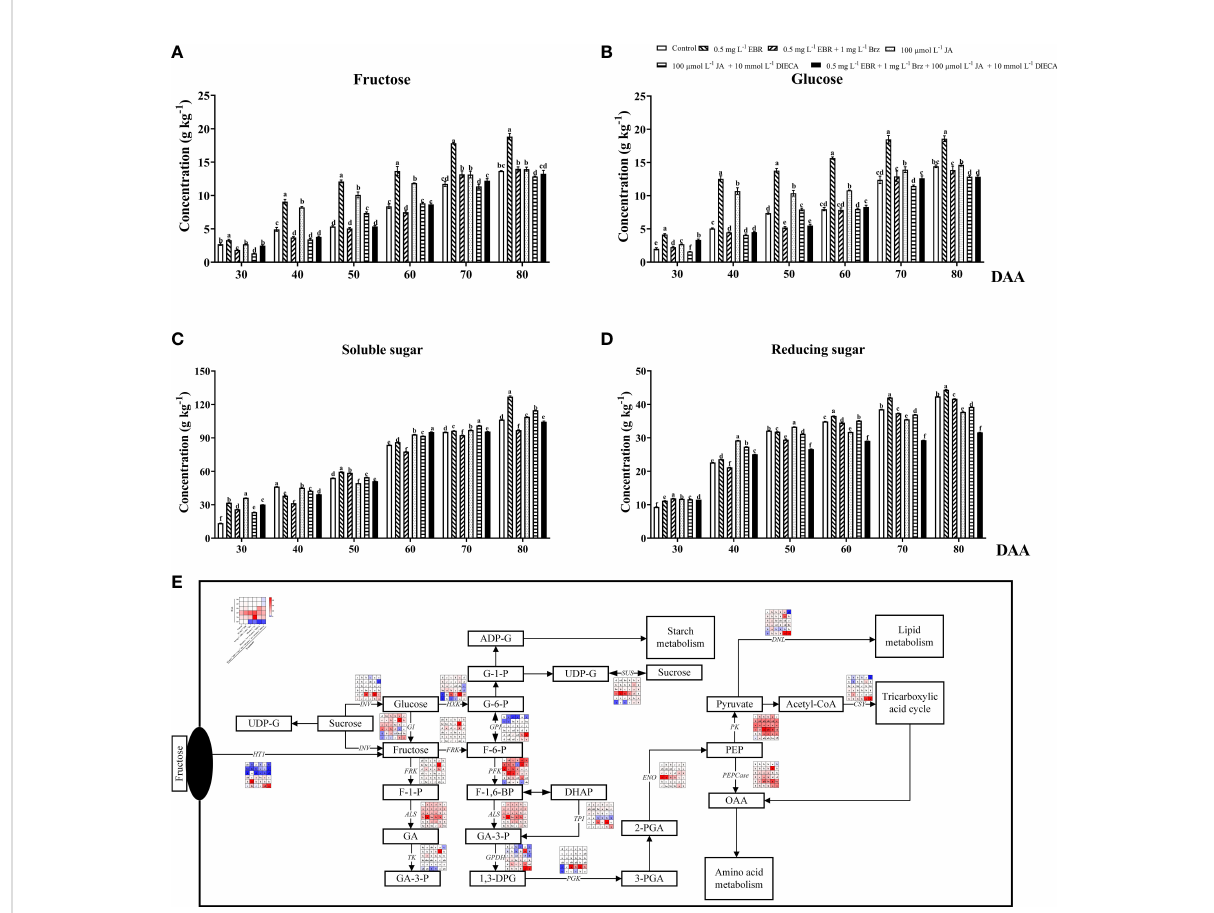
FIGURE 3 Effect of exogenous EBR, JA and their signaling inhibitors on sugars formation and transportation. (A-D) Effect of exogenous EBR, JA and their signaling inhibitors on different types of sugar content in different treatment groups (Control, 0.5 mg L -1 EBR, 100 m mol L -1 JA, 0.5 mg L -1 EBR + 1 mg L -1 Brz, 100 m mol L -1 JA + 10 mmol L -1 DIECA, 0.5 mg L -1 EBR + 1 mg L -1 Brz + 100 m mol L -1 JA + 10 mmol L -1 DIECA) at six sampling stages (DAA 30, 40, 50, 60, 70, 80). (A) Fructose contents. (B) Glucose contents. (C) Soluble sugar contents. (D) Reducing sugar contents. The levels of each sugar were expressed in the form of a histogram. Error bars = ± SE (n ≥ 3). Signi fi cant differences among samples have been displayed by a – f letters (one-way ANOVA, P<0.05). (E) Expression of genes involved in sugars biosynthesis, metabolic and transporting pathways in